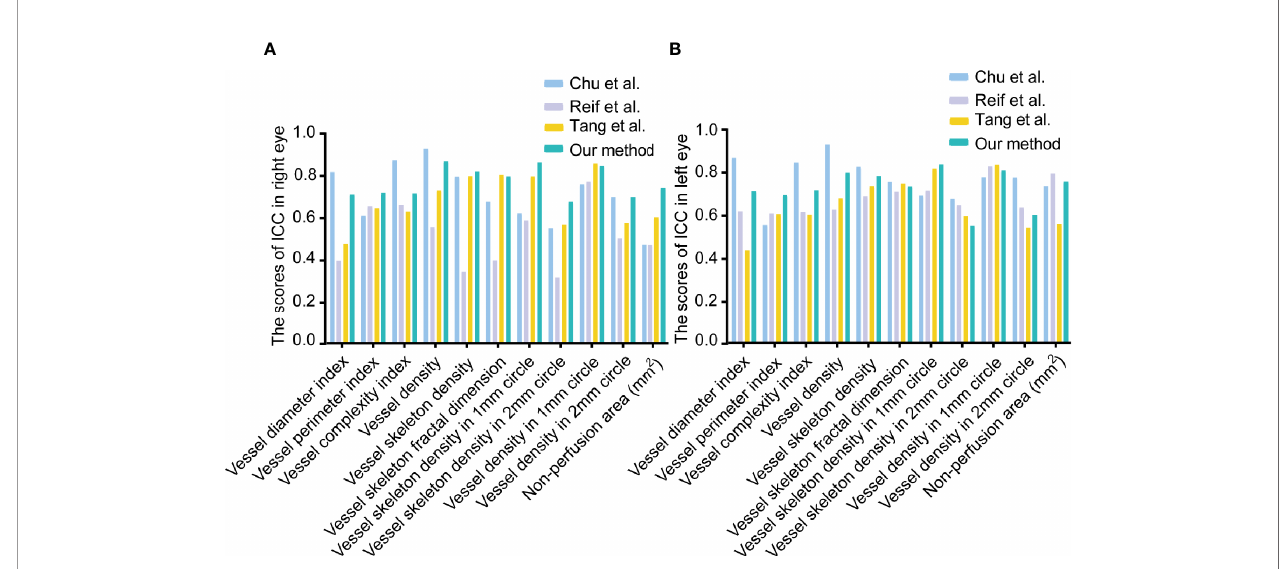
FIGURE 3 | The scores of intraclass correlation coef fi cient (ICC) of OCTA quantitative metrics. (A) The scores of ICC in the right eyes. (B) The scores of ICC in the left